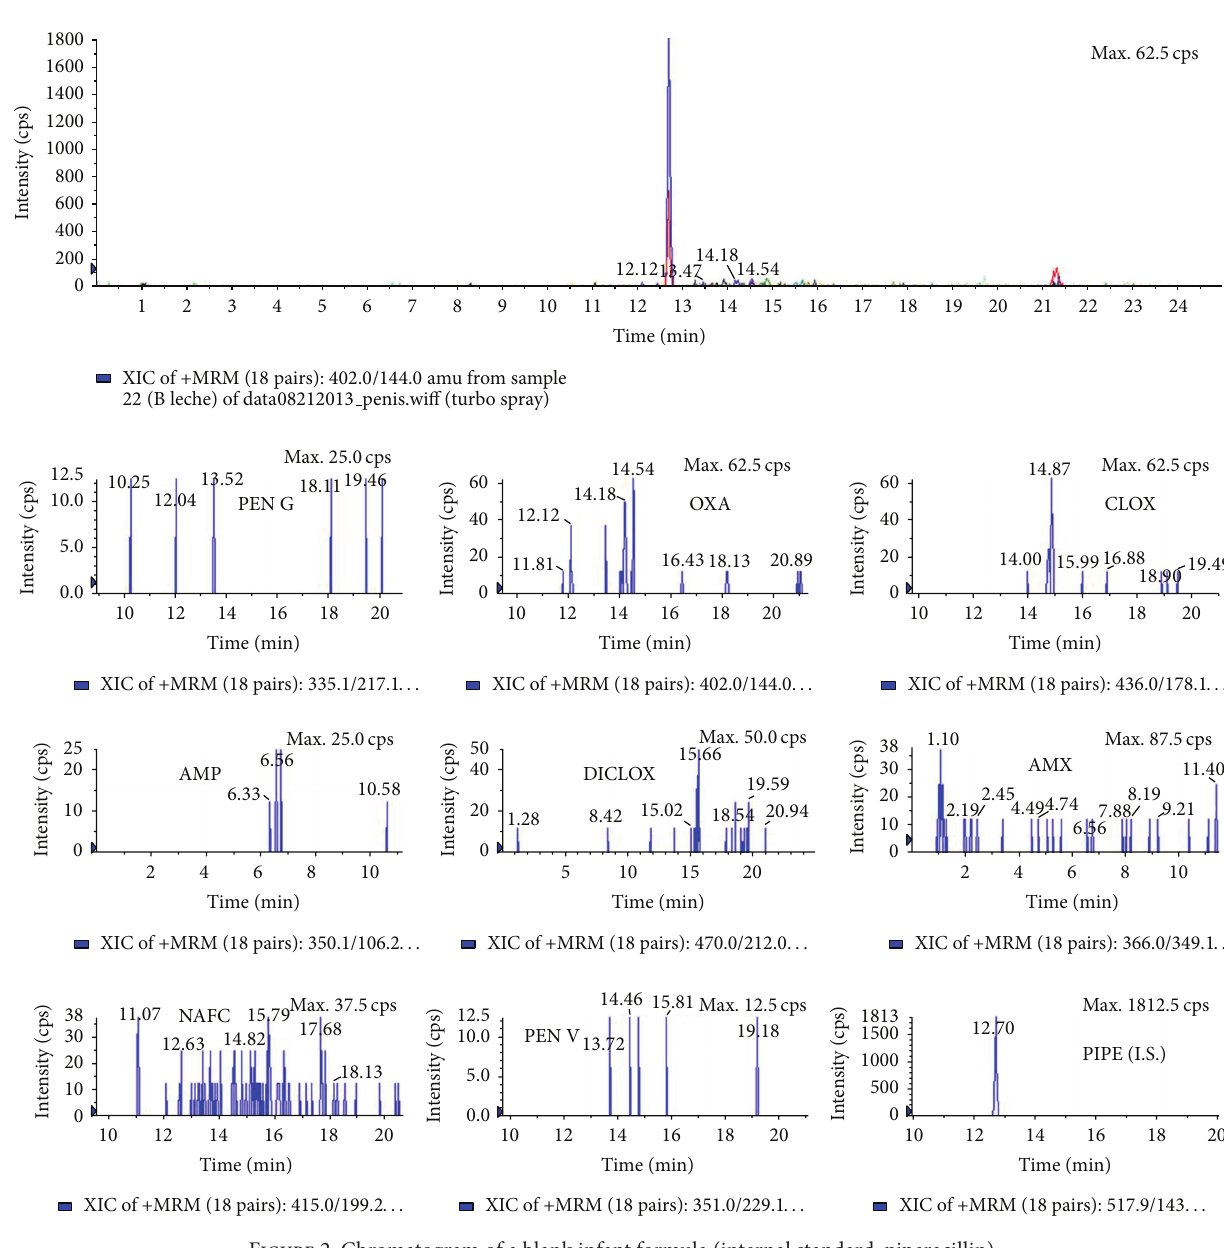
Figure 2: Chromatogram of a blank infant formula (internal standard: